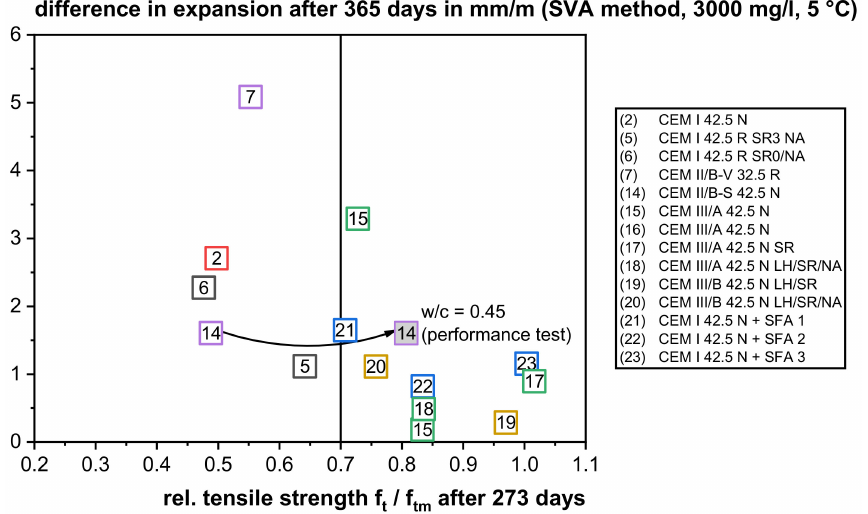
Figure 9. Difference in expansion (SVA method, 3000 mg SO 42 − /L, 5 ◦ C) after 365 days over the relative tensile strength f t /f tm after 273 days.